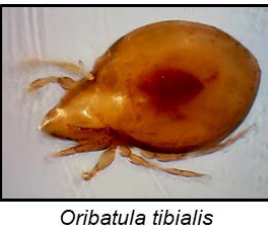
Figure 10. O. tibialis photo by Matthew Shepherd (http://www.soilbiodiversityuk.myspecies.info/ taxonomy/term/16371/media).